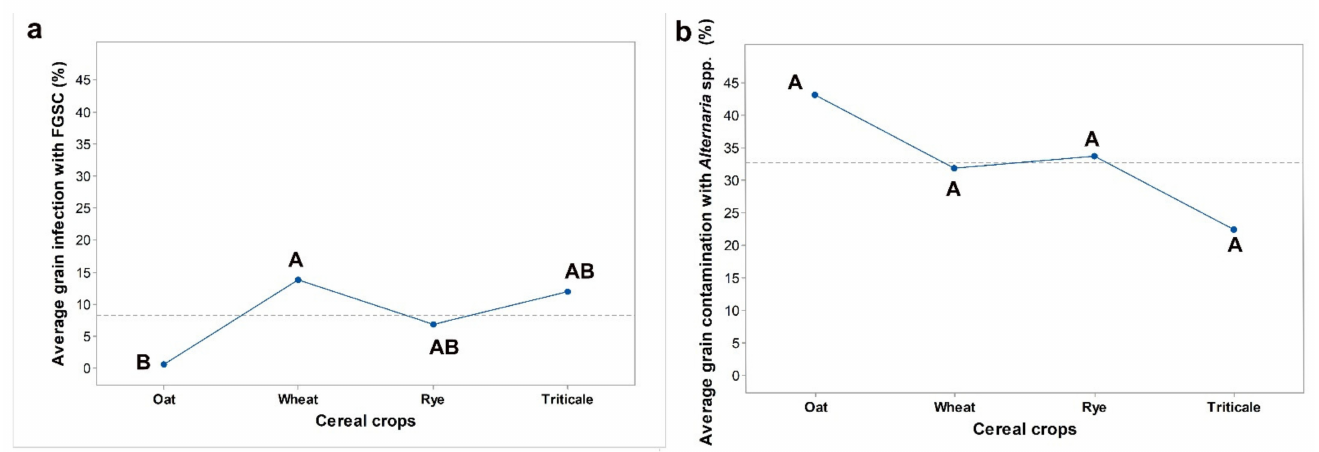
Figure 1. Average FDKs ( a ) and ACKs ( b ) on wheat, rye, triticale and oat cultivated as monocrops and intercropped with pea. Tukey’s pairwise comparisons of means were performed with 95% confidence. The means that do not share the same letter are significantly